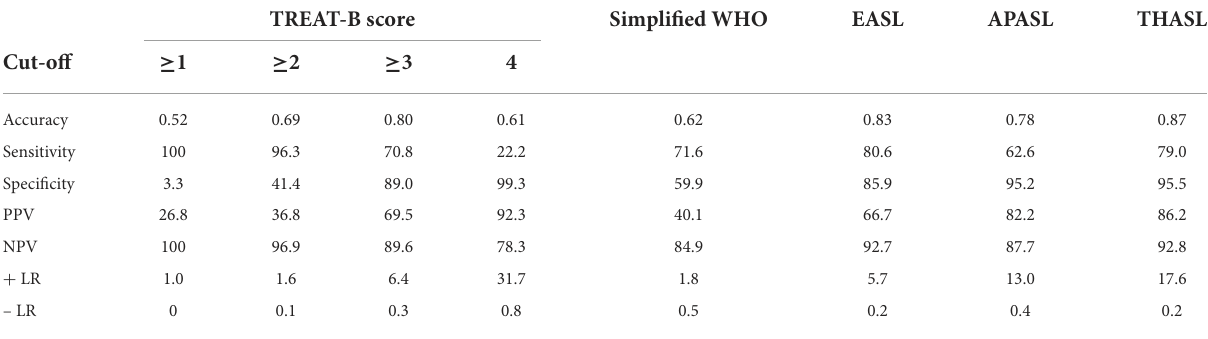
TABLE 2 Performance of the international guidelines to select patients eligible for antiviral therapy in reference to the AASLD 2018 guideline. TREAT-B score Simplified WHO EASL APASL THASL